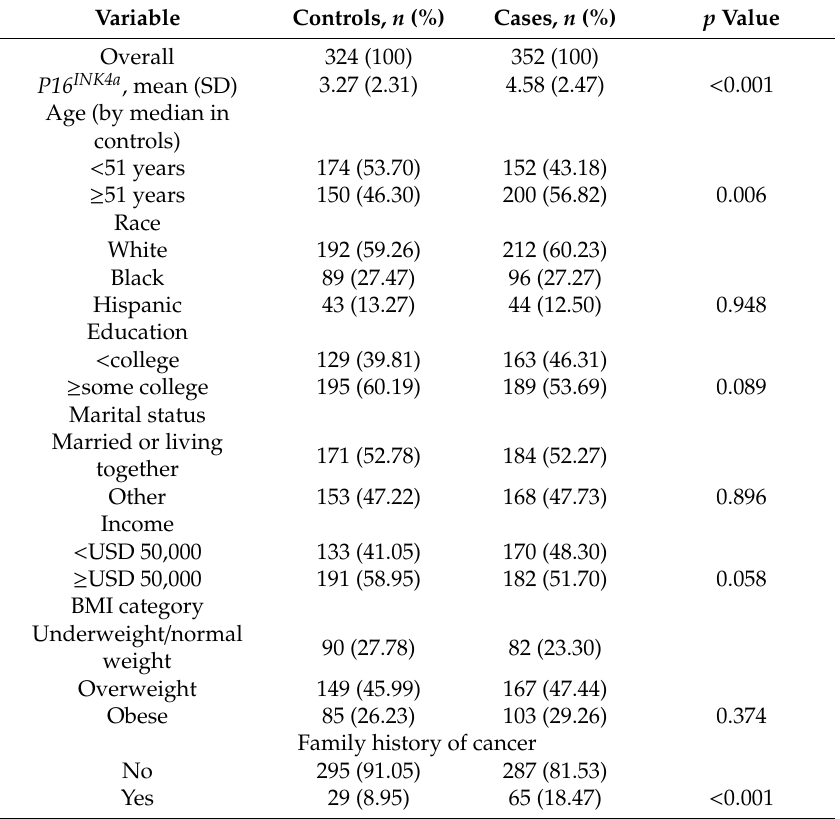
Table 1. Distribution of characteristics among participants by case–control